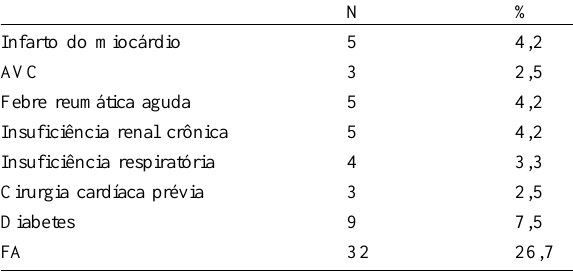
Tabela 1. Dados clínicos pré-operatórios.